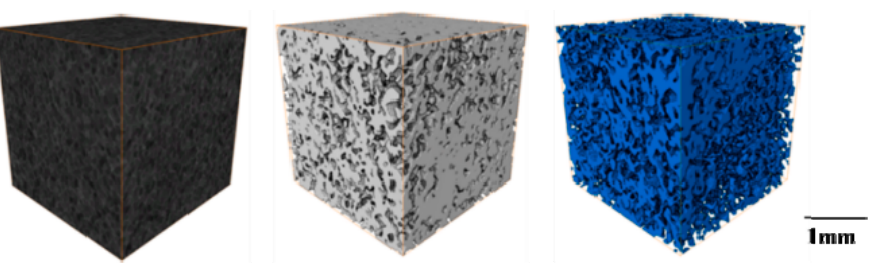
Figure 10. Pore structure under shear.